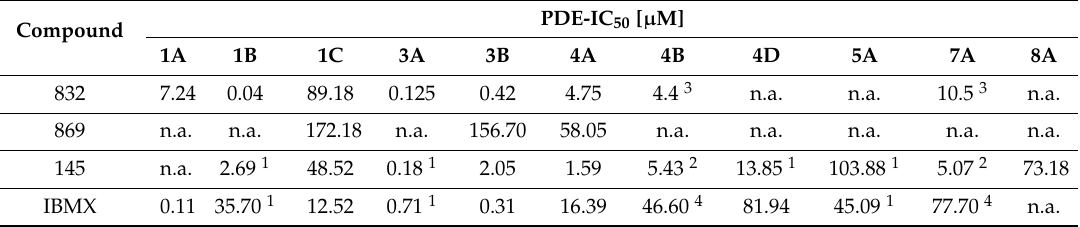
Table 1. Compounds 832, 869, and 145 as PDE inhibitors.